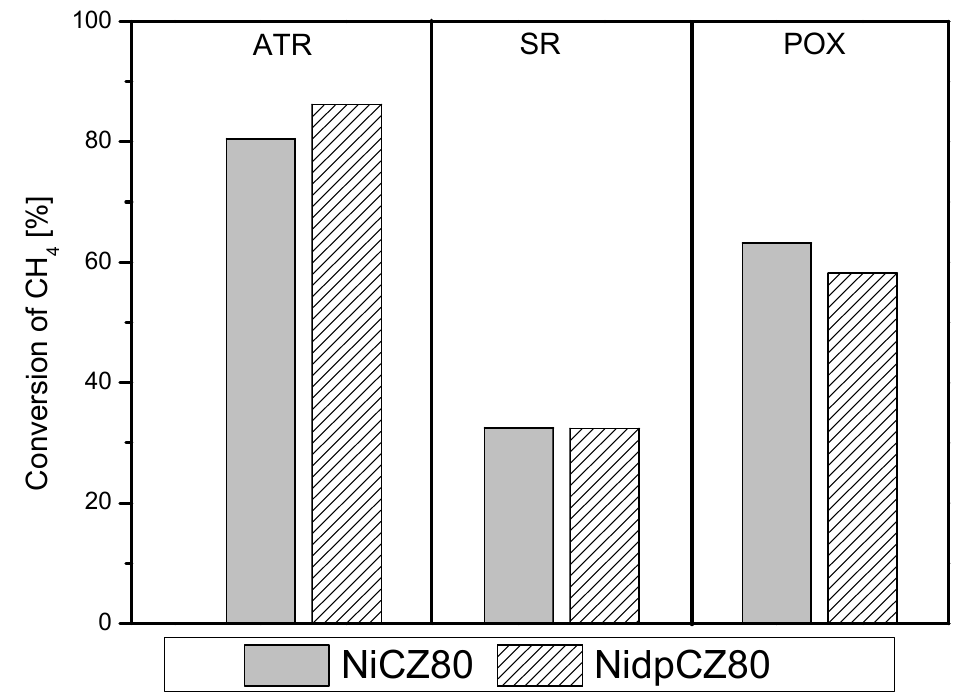
Figure 7. Conversion of methane CH 4 for NiCZ80 and NidpCZ80 under ATR, SR, and POX conditions at T = 800 °C GSVH = 120,000 h − 1 .